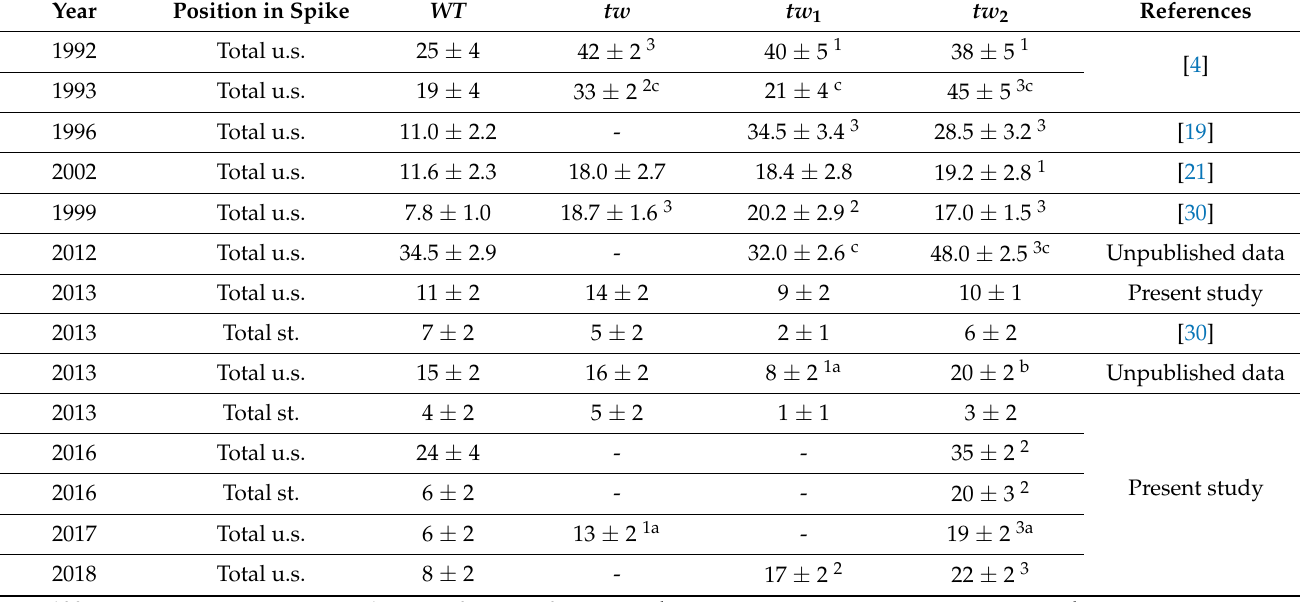
Table 1. Variation in MGG frequencies (%) in barley tweaky spike ( tw ) allelic mutants in different years of seed material growth. Year Position in Spike WT